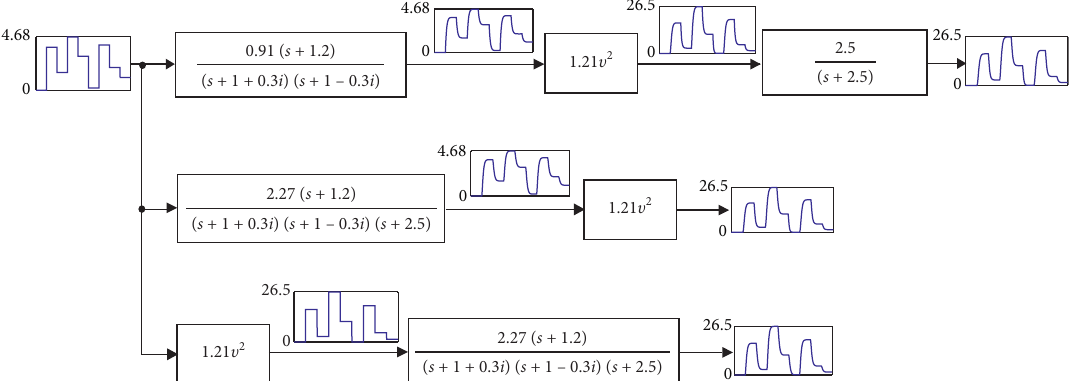
Figure 5: Example of search space limits for static nonlinearity in Wiener, Hammerstein, and Wiener–Hammerstein models when they are excited with a multistep